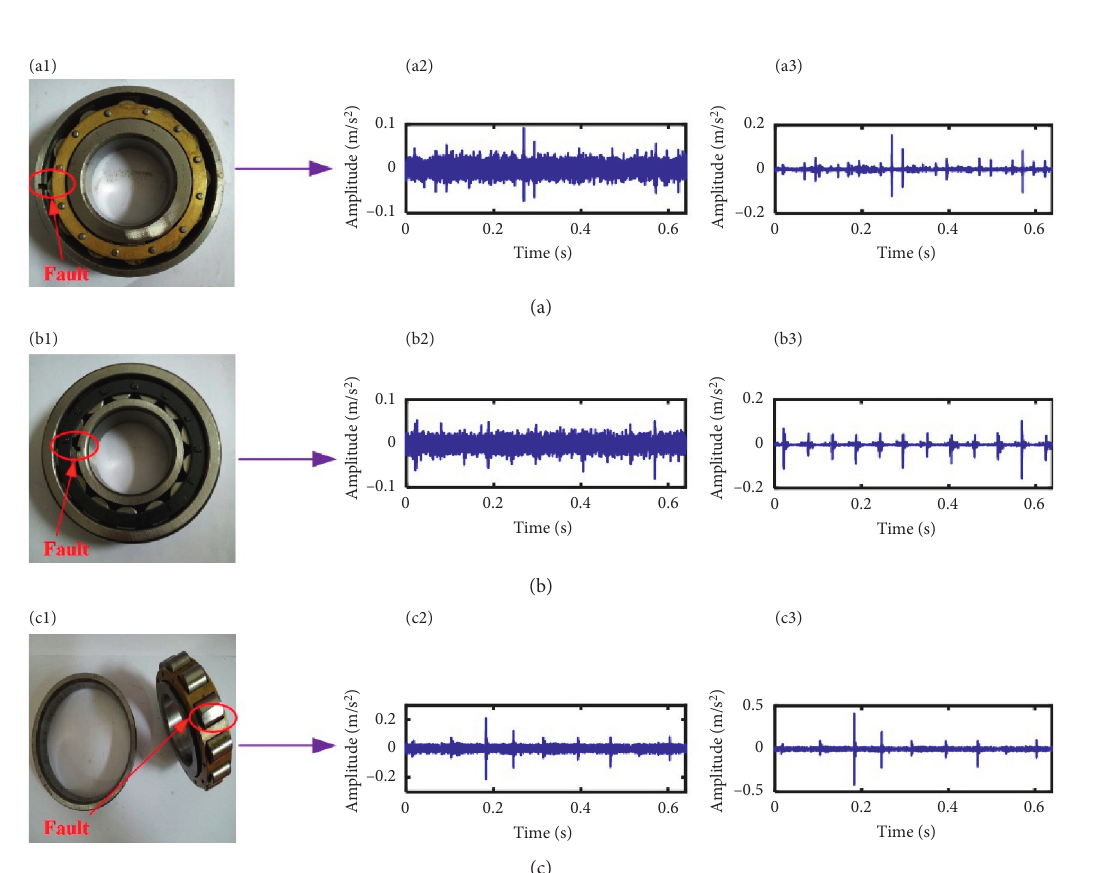
Figure 8: Fault bearings, signal collected from test bench, and their purified signals using TV-MM: (a) (a1) the outer race failure of NUP311E, (a2) measured outer race failure vibration signal, and (a3) purified signal using TV-MM; (b) (b1) inner race failure of NJ311E, (b2) measured inner race failure vibration signal, and (b3) purified signal using TV-MM; (c) (c1) rolling element failure of NUP311E, (c2) measured rolling element failure vibration signal, and (c3) purified signal using TV-MM.